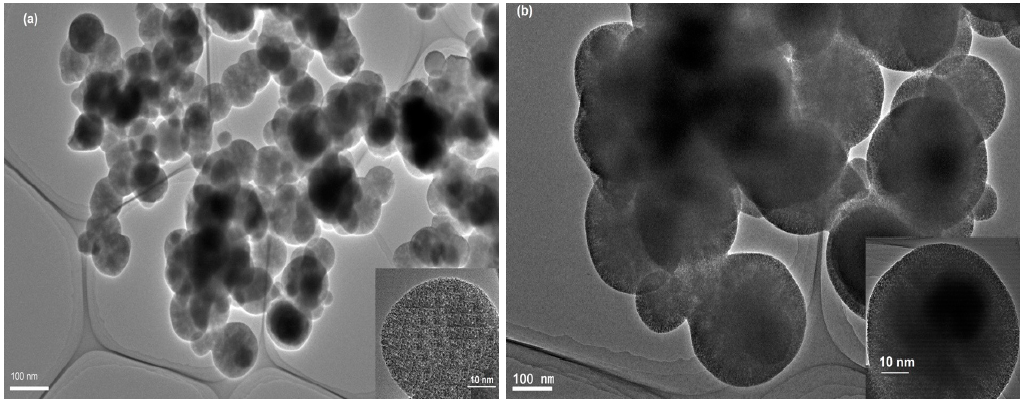
Figure 4. TEM micrographs ( a ) HSNPs-1 and ( b ) HSNPs-2.